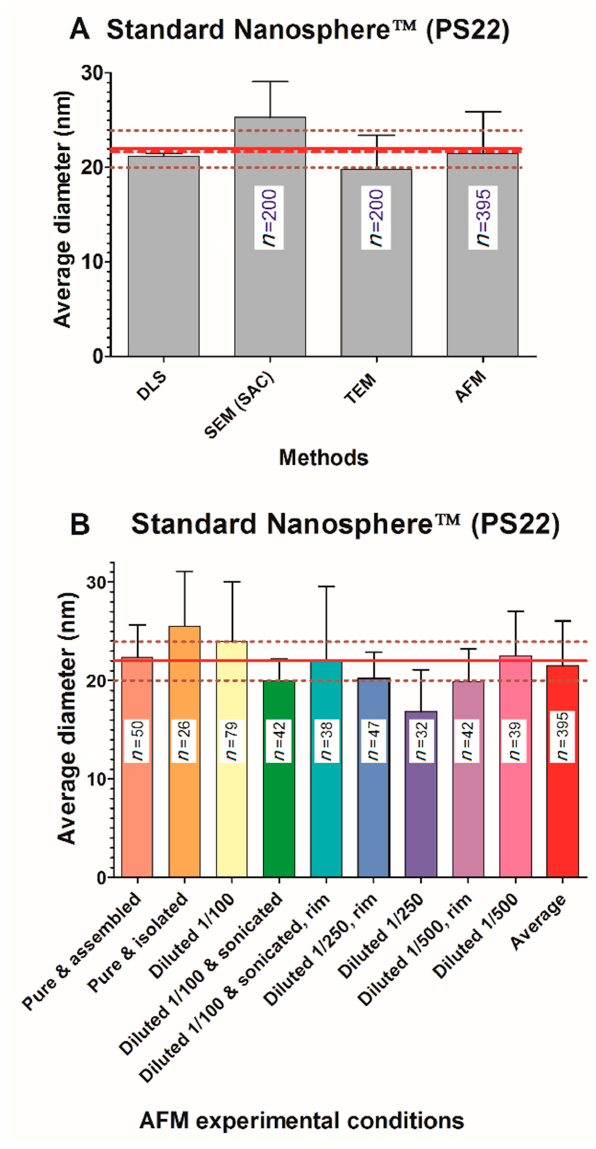
Figure 2. Size measurement of nanosphere standard particles (PS22) given at a reference diameter of 22 nm ( thick red lines ) and a standard deviation of ± 2 nm ( dotted red lines ). N represents the number of measurements obtained in each method. ( A ) Measures were performed with Dynamic Light Scattering (DLS), Scanning Electron Microscopy (SEM) in Saclay (SAC), Transmission Electron Microscopy (TEM), and Atomic Force Microscopy (AFM). The red dashed line corresponds to the average value of all the five applied methods (for visibility, standard deviation is not shown). ( B ) Size measurements performed solely with AFM using nine different experimental conditions where Pure indicates no dilution, Diluted indicates dilution in pure water, assembled indicates that size was obtained by measuring the length of aligned PS22 and divided by the number of particles, sonicated indicates that sonication was performed on the sample before imaging, and rim indicates that measurements were performed at the edge of deposited particles on mica.